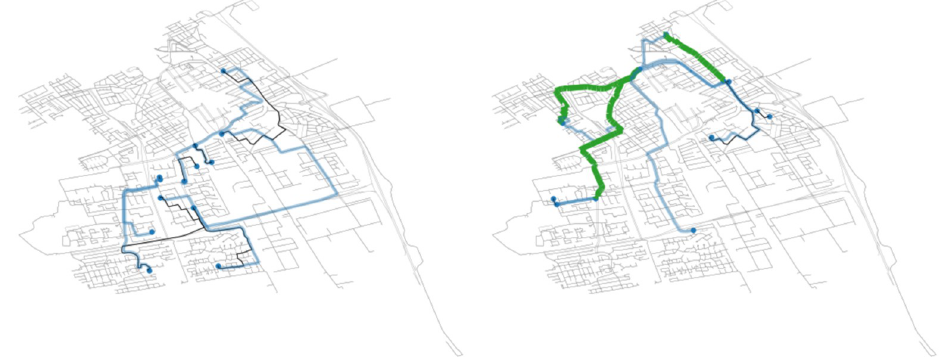
Fig 8. Traces of rides for a single simulated vehicle without (left) and with pooled ride services (right). Blue— single traveller on-board, Green—several travellers sharing a ride, Black—empty vehicle trip.